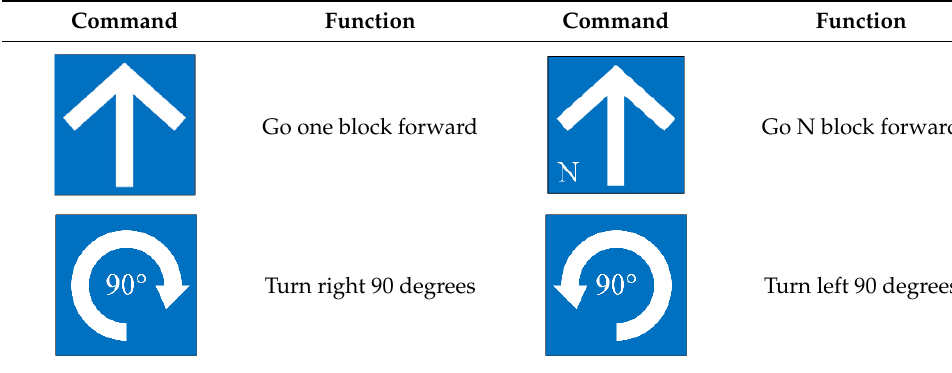
Table 2. Command function table.